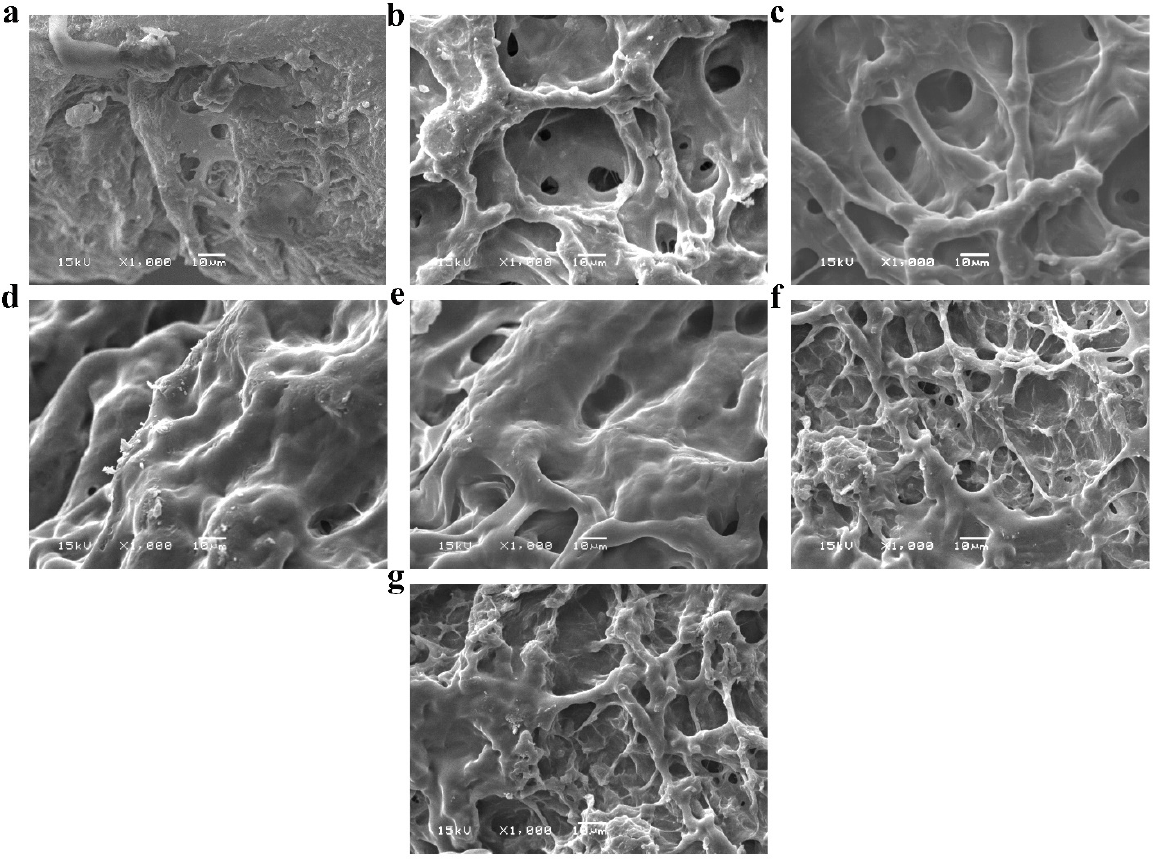
Figure 3. SEM images reveal surface morphologies of ( a ) PVA, ( b ) PVA-M0.1, ( c ) PVA-M0.25, ( d ) PVA-M0.5, ( e ) PVA-M0.5-K0.1, ( f ) PVA-M0.5-K0.25, and ( g ) PVA-M0.5-K0.5 composite sponges at a magnification of 1000×.